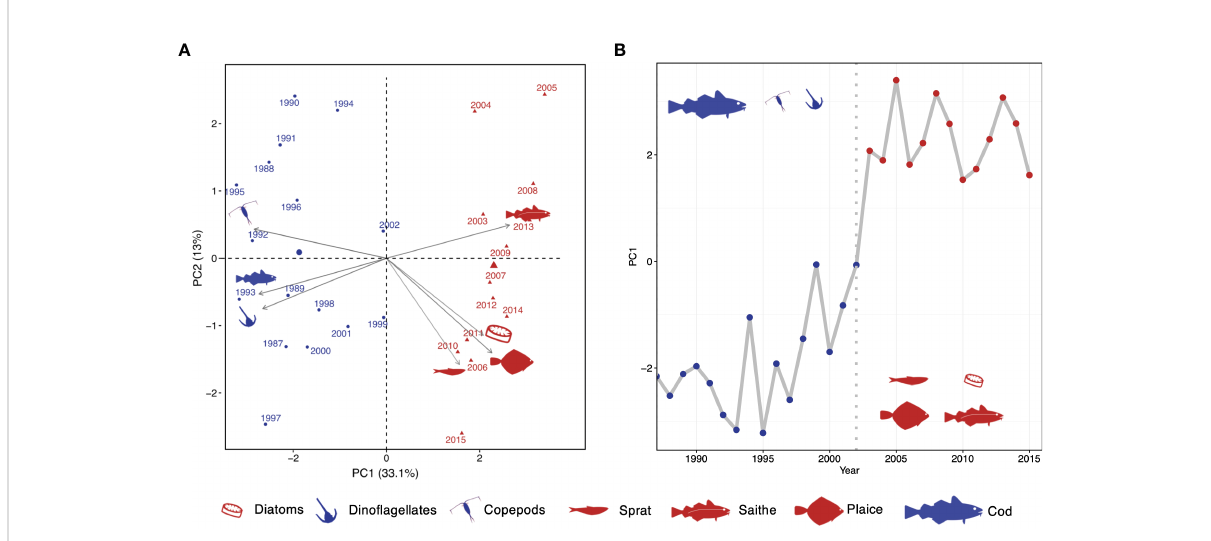
FIGURE 2 Regime shift in the North Sea ecosystem. (A) Biplot of principal components PC1 and PC2 (explained variance in brackets) associating the periods of the two ecosystem regimes to dominating species/taxonomic groups; only species/taxonomic groups with the highest loadings in PC1 and which are emergent species in PC2 are shown; for full PCA output see SI Figure 4. (B) Abrupt shift in scores of PC1 evaluated by statistical change point